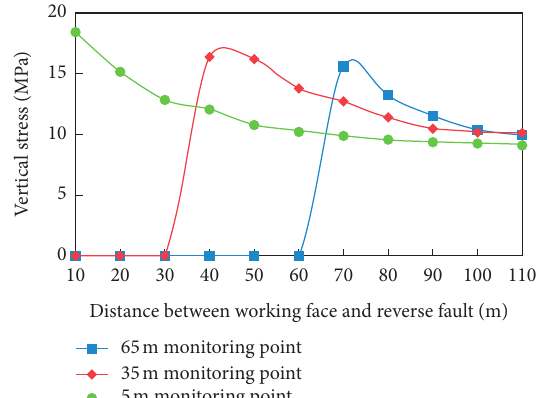
Figure 5: Variation curve of the vertical stresses at the monitoring points in hanging-wall